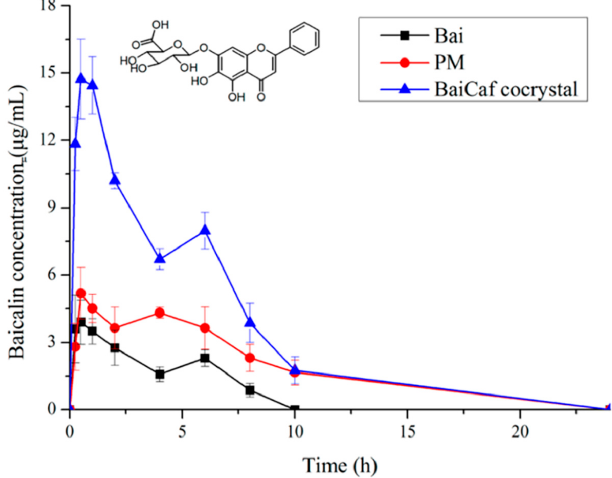
Figure 9. Plasma BG concentration–time curves of the crystalline Bai, PM and BaiCaf cocrystal (data are expressed as means ± SD, n = 6). Adapted from [69] with permission. Copyright © 2017 American Chemical Society.